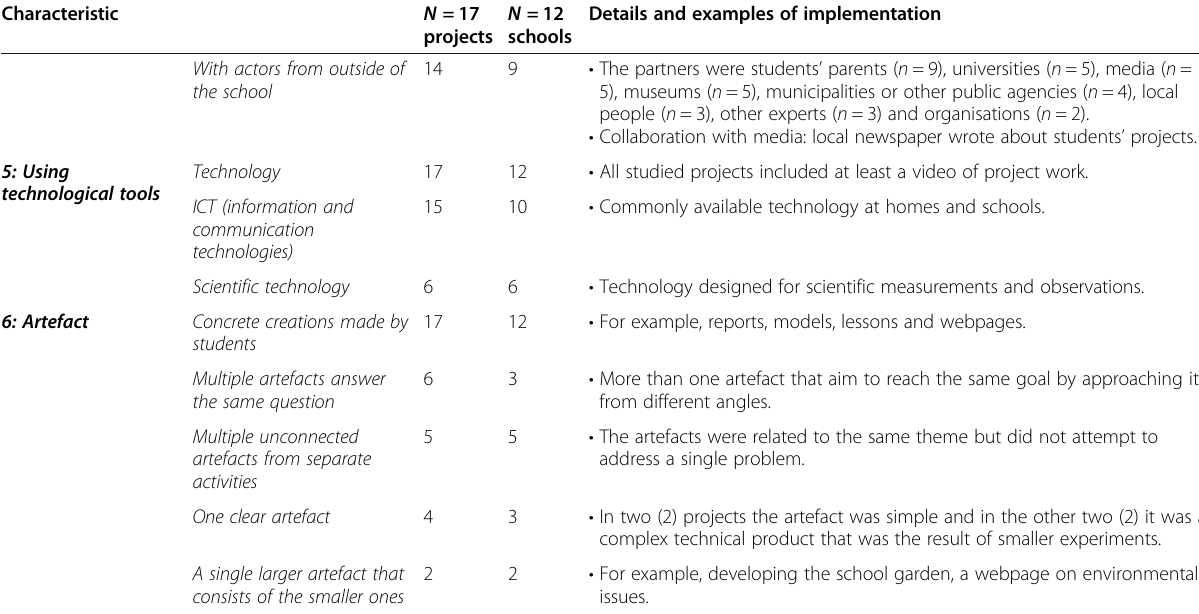
Table 6 Visibility of key characteristics and their implementation in practice in the PBL units (Continued) Characteristic N = 17 N = 12 Details and examples of implementation projects schools With actors from outside of the